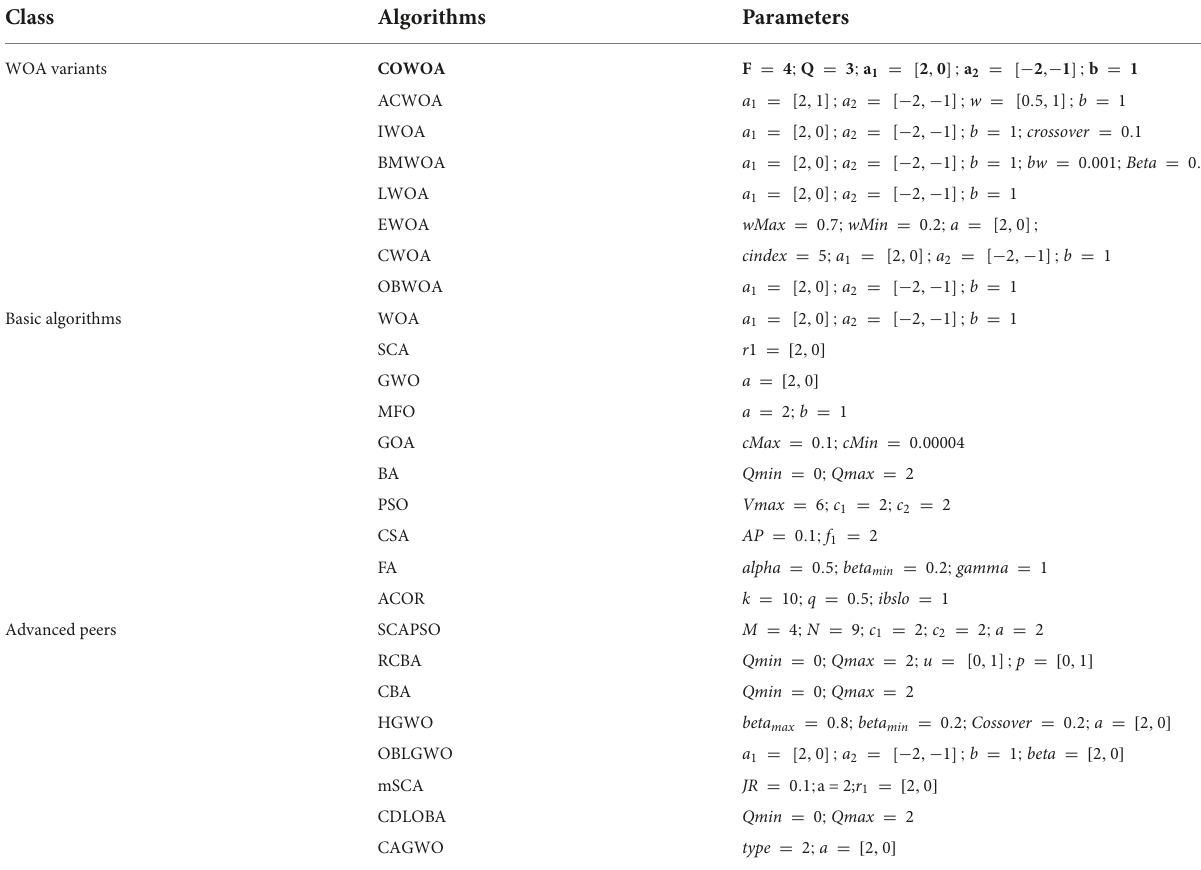
TABLE 2 Description of the parameters in involved